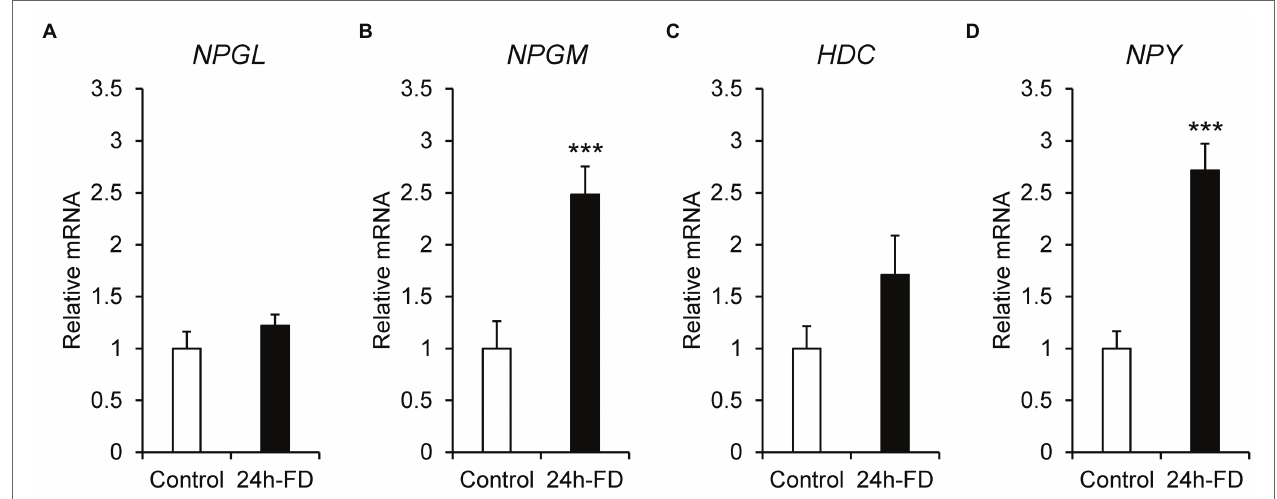
FIGURE 1 | mRNA expression levels, neurosecretory protein GL ( NPGL ; A ), neurosecretory protein GM ( NPGM ; B ), histidine decarboxylase ( HDC ; C ), neuropeptide Y ( NPY ; D ) in the mediobasal hypothalamus in the 24 h food deprivation experiment. Data are expressed as the mean ± SEM ( n = 5–6). Data were analyzed by Student’s t -test. An asterisk indicates a statistically significant difference (*** p <